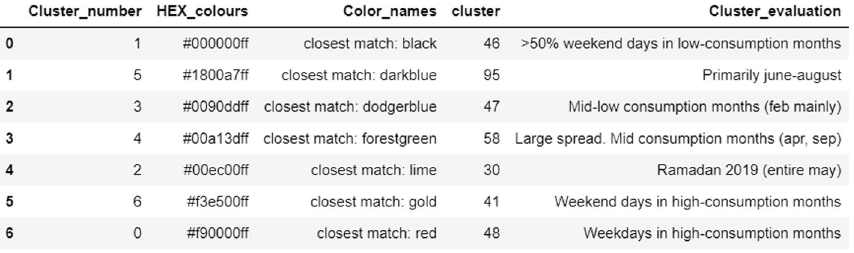
Fig. 16 Dataframe for the seven clusters of Lombok electricity consumption in